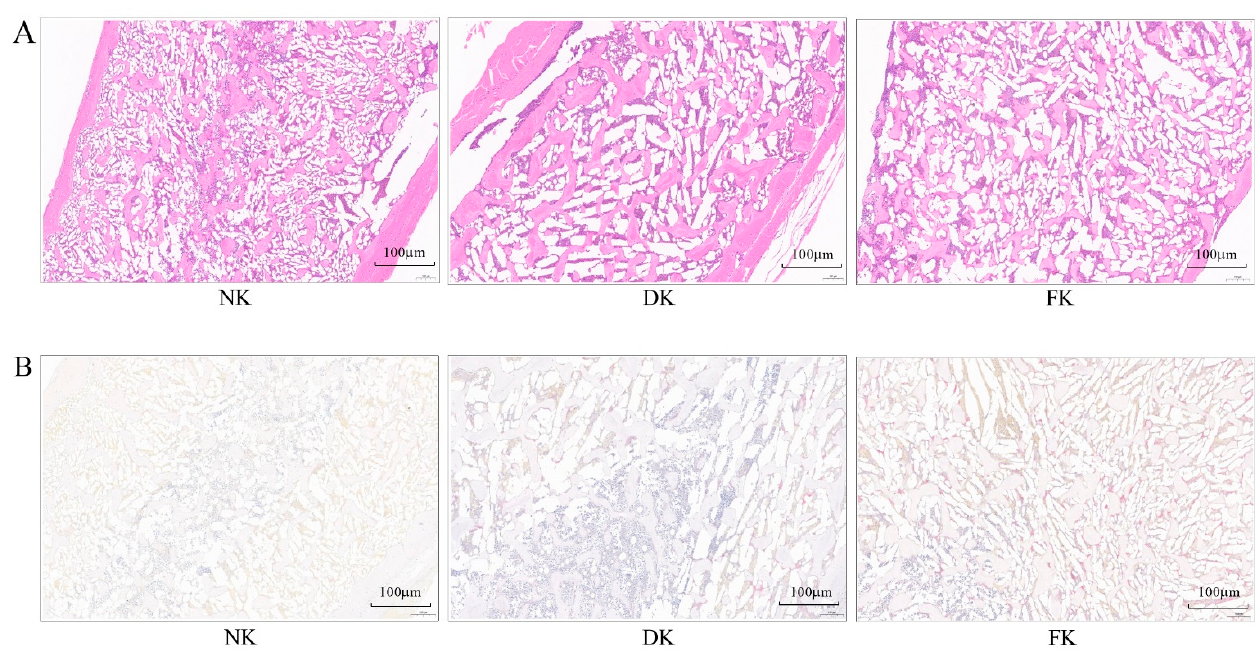
Figure 2. The results of hematoxylin-eosin (H&E) staining ( A ) and tartrate resistant acid phosphatase (TRAP) staining ( B ) of the keel bone in each group. NK = normal keel bone; DK = deviated keel bone; FK = fractured keel bone.